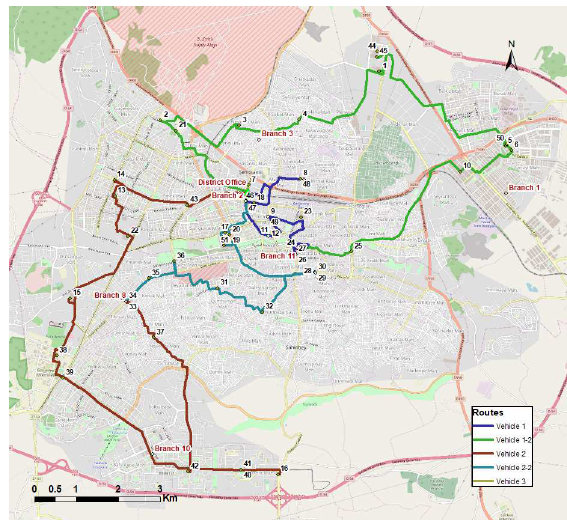
Figure 8. Solution of GB-3.